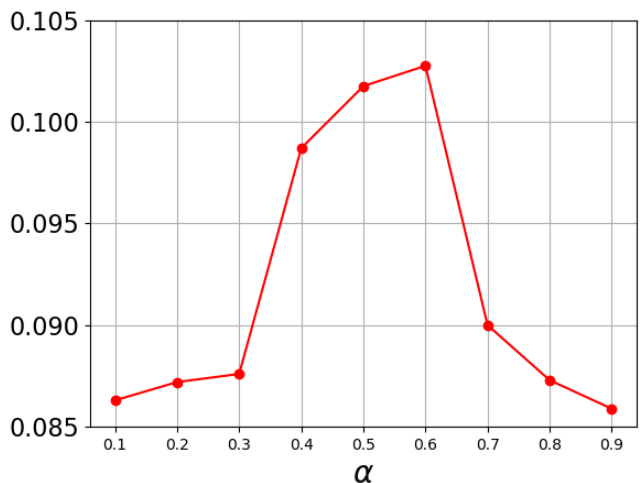
Figure 6. HR@5 with respect to the value of α